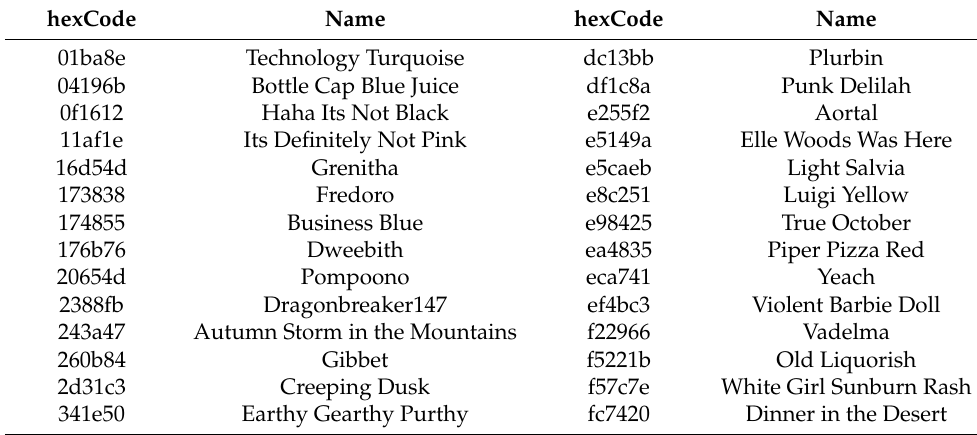
Table 7. Examples of color names collected from colornames.org.